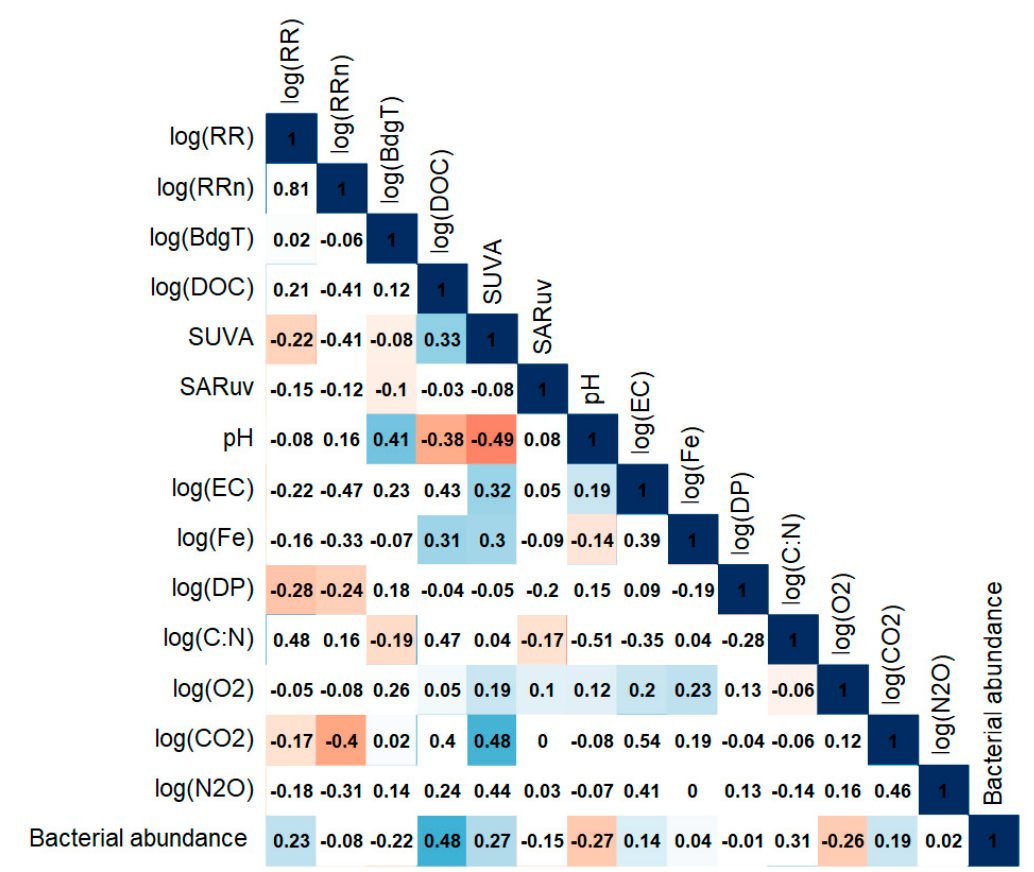
Figure 5. Correlation plot of log transformed response variables log(RR), log(RRn), and log(BdgT), and the 12 selected explanatory variables. Blue and red coloured squares indicate positive and negative significant correlation coefficients ( p < 0.05), respectively.